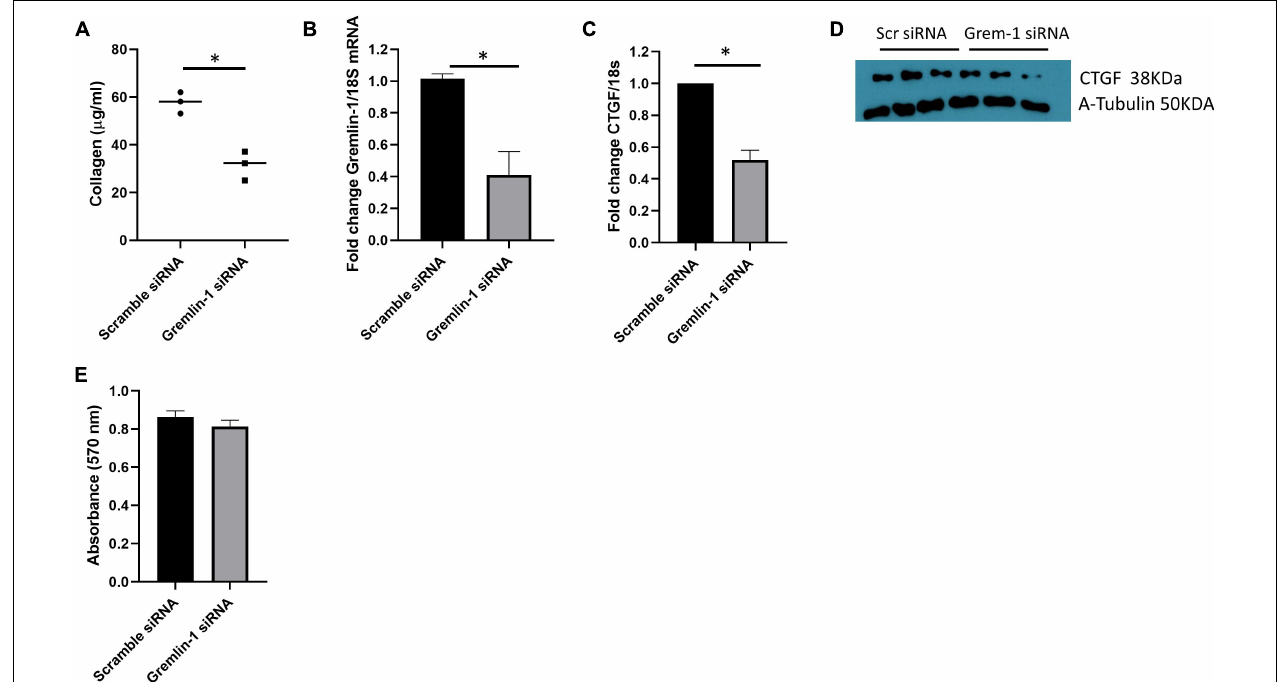
FIGURE 7 | Knockdown of Gremlin-1 in SSc mediates reduced ECM in SSc cells. (A) SSc fibroblasts from 3 donors were transfected with scramble or Gremlin-1 siRNA and collagen was quantified by Sircoll assay. Each point is individual donor and the horizontal bar is the mean, P = 0.0038; Student’s t -test; n = 3. (B) Confirmation of Gremlin-1 knockdown by qRT-PCR after scramble or Gremlin-1 siRNA, P = 0.0022; Student’s t -test; n = 3. (C) CTGF levels after siRNA scramble control or Gremlin-1 siRNA transfection. Data is normalized to 18S and shown as fold change to scramble siRNA controls, P = 0.0002; Student’s t -test; n = 3. (D) Western blot of CTGF and α -tubulin to confirm equal protein loading after transfection of scramble or siRNA targeting Gremlin-1 in three different SSc donors. (E) Absorbance at 570 nm after siRNA Gremlin-1 or scramble control siRNA. No significant difference, P = 0.13; Student’s t -test; n = 3. The meaning of ‘*’ is significantly different students t test.